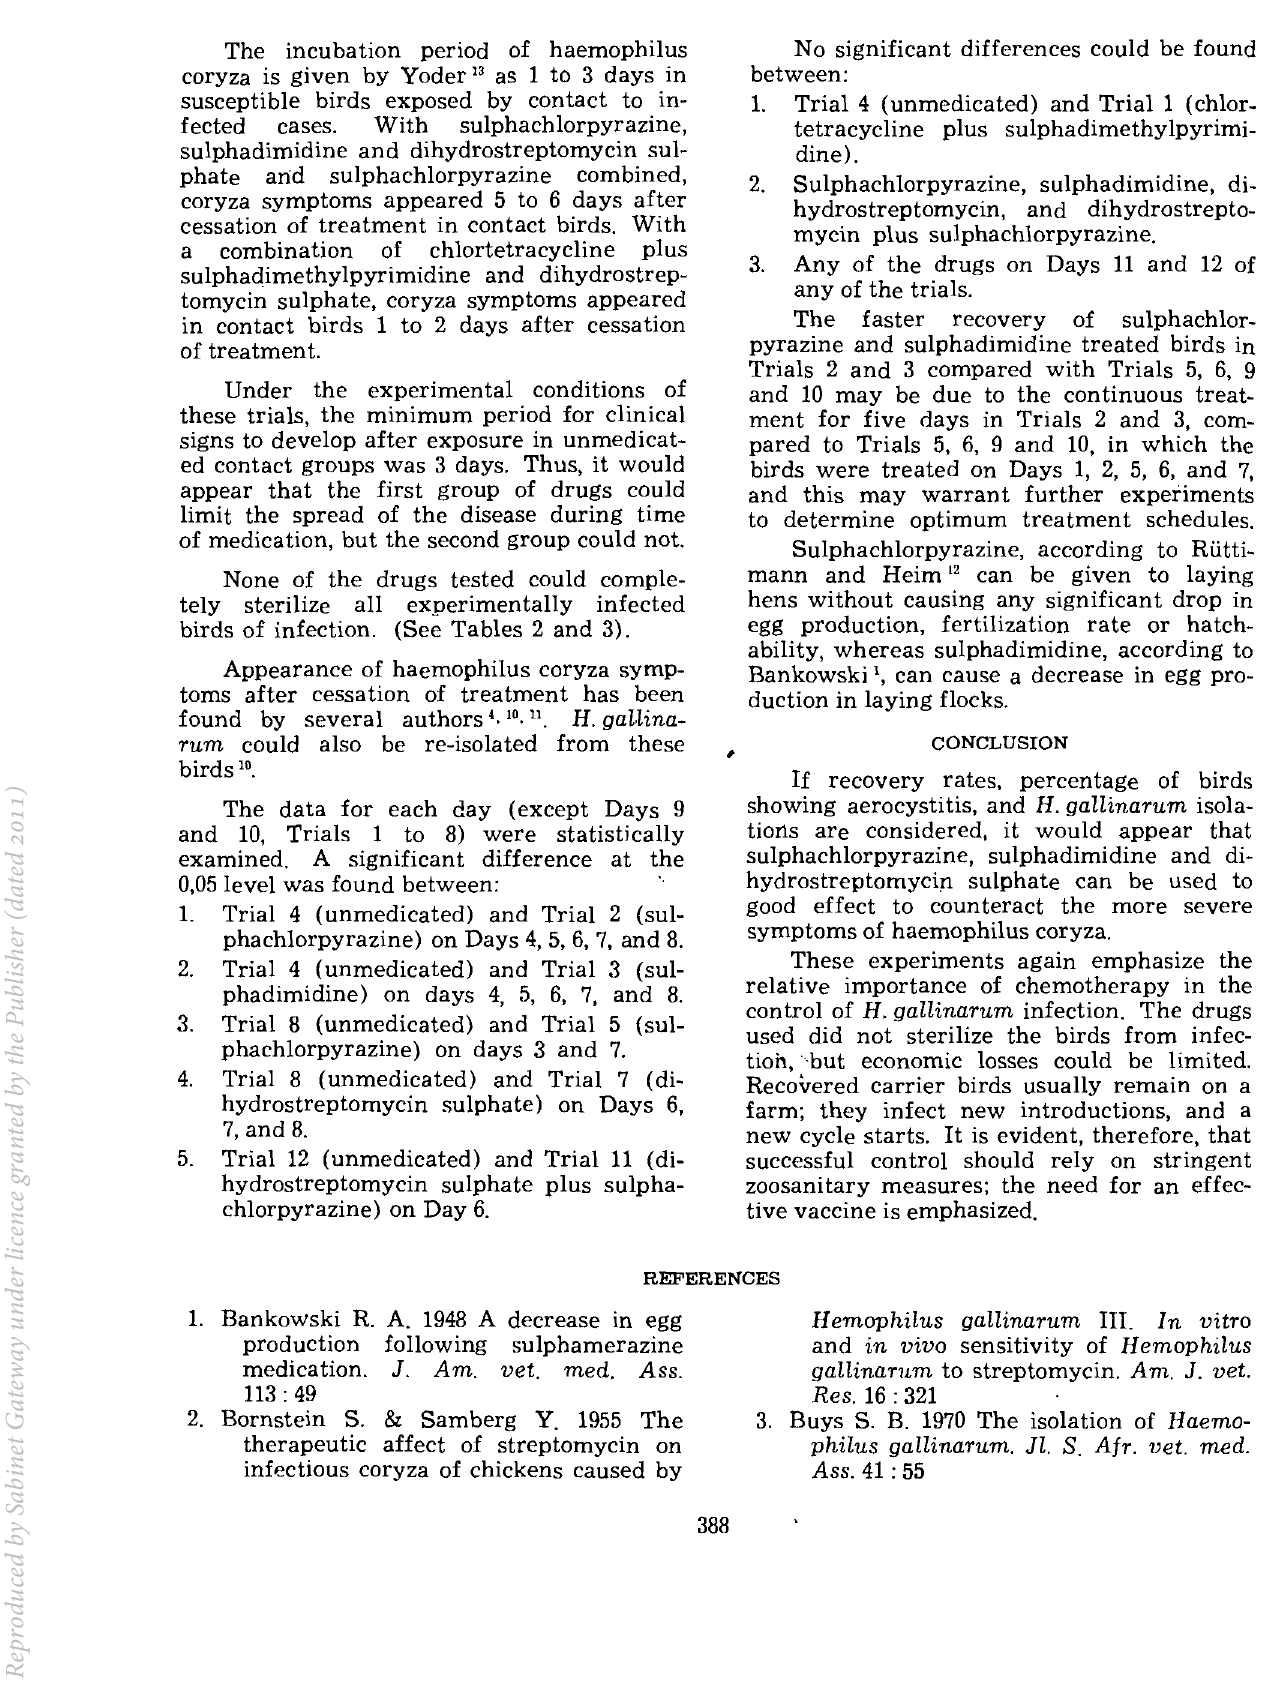
mycin plus sulphachlorpyrazine. 3. Any of the drugs on Days 11 and 12 of any of the trials. The faster recovery of sulphachlor pyrazine and sulphadimidine treated birds in Trials 2 and 3 compared with Trials 5, 6, 9 and 10 may be due to the continuous treat ment for five days in Trials 2 and 3, com pared to Trials 5, 6, 9 and 10, in which the birds were treated on Days 1, 2, 5, 6, and 7, and this may warrant further experiments to determine optimum treatment schedules. Sulphachlorpyrazine, according to Rutti mann and Heim 12 can be given to laying hens without causing any significant drop in egg production, fertilization rate or hatch ability, whereas sulphadimidine, according to Bankowski 1, can cause a decrease in egg pro duction in laying flocks. CONCLUSION ; If recovery rates, percentage of birds showing aerocystitis, and H. gaHinarum isola tiorts are considered, it would appear that sulphachlorpyrazine, sulphadimidine and di hydrostreptomycin sulphate can be used to good effect to counteract the more severe symptoms of haemophilus coryza. These experiments again emphasize the relative importance of chemotherapy in the control of H. gallinarum infection. The drugs used did not sterilize the birds from infec tion,-but economic losses could be limited. Recovered carrier birds usually remain on a farm; they infect new introductions, and